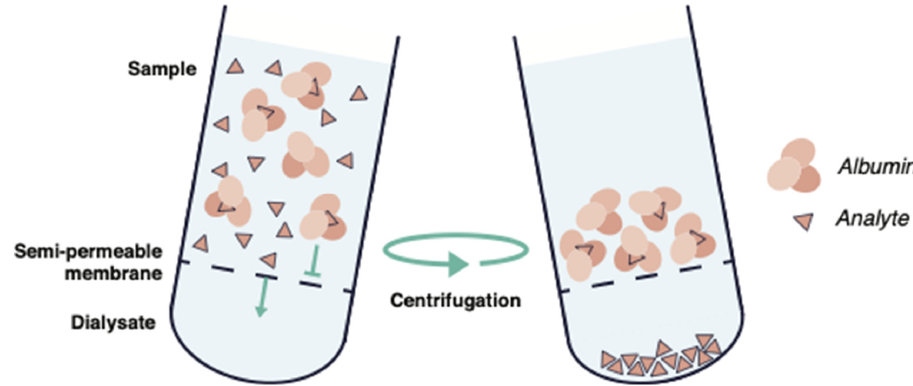
Figure 4. Schematic illustration of ultracentrifugation.